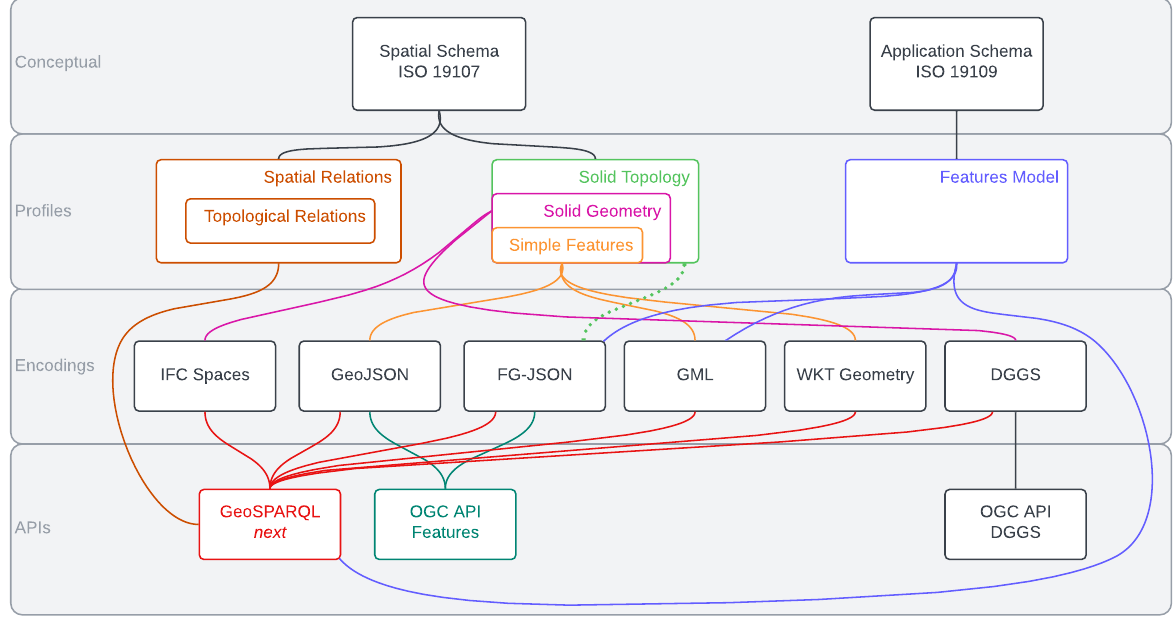
Figure 4. Proposed support for 3D within existing spatial